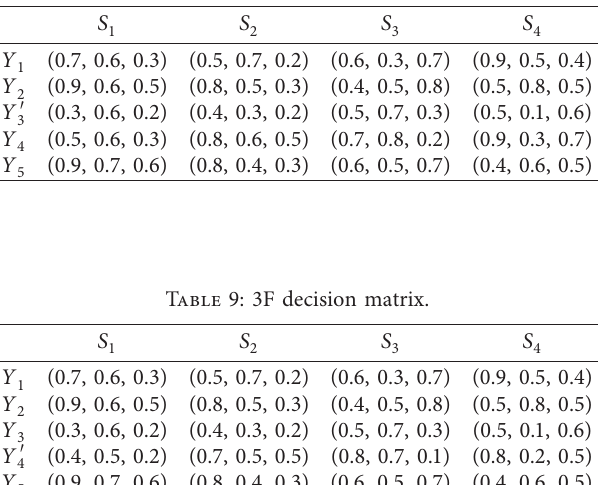
Table 8: 3F decision matrix.